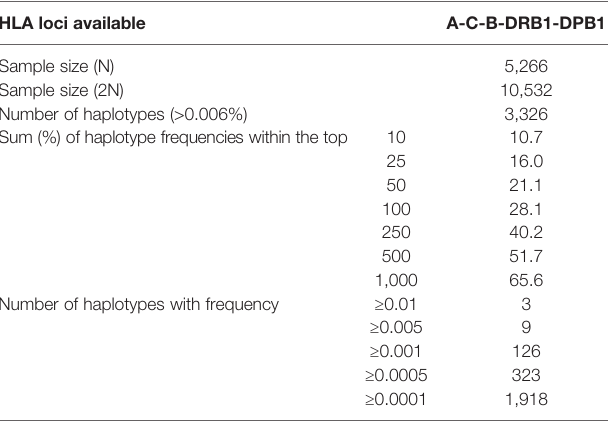
TABLE 1 | Characteristics of the haplotypes of Hong